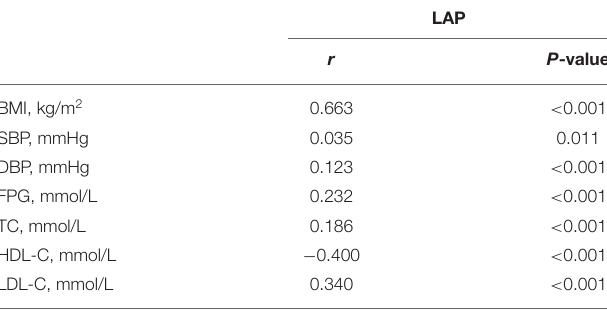
TABLE 2 | Correlation between the LAP index and cardiovascular risk factors after adjusted for age and